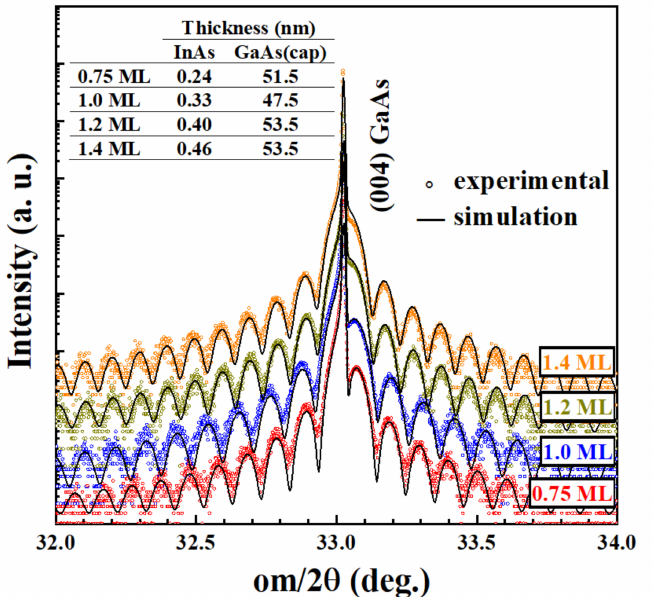
Figure 2. Experimental and simulated XRD patterns of all samples for the symmetrical (004) plane. The inserted table indicates the calculated thickness of ultrathin InAs layers and GaAs cap